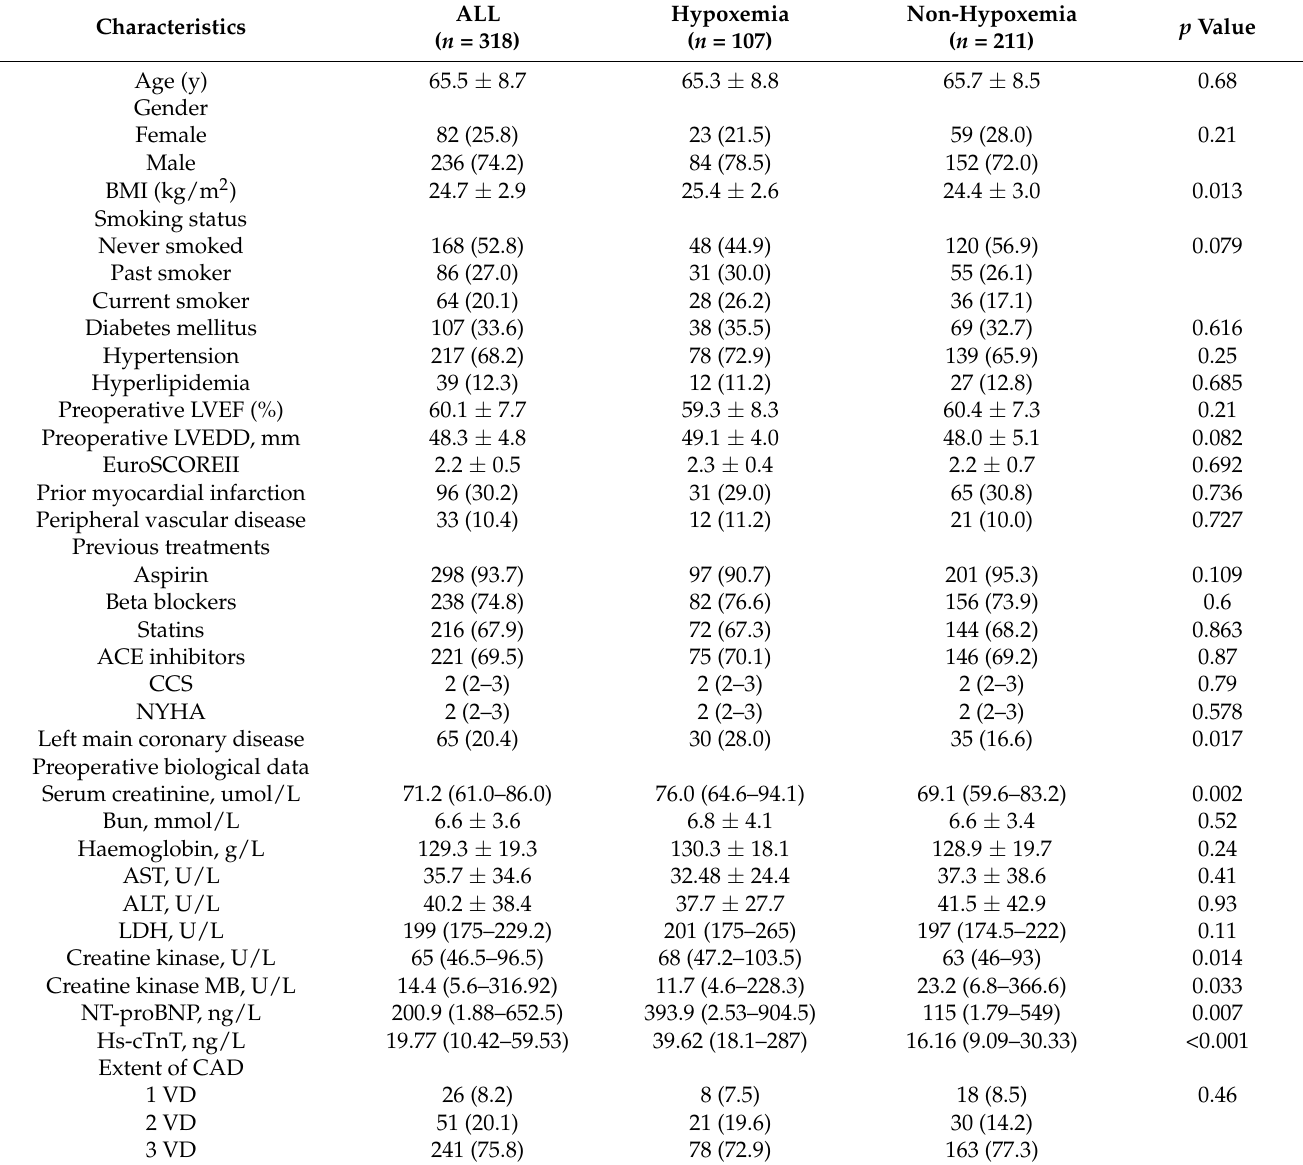
Table 1. Demographic and clinical characteristics of patients undergoing